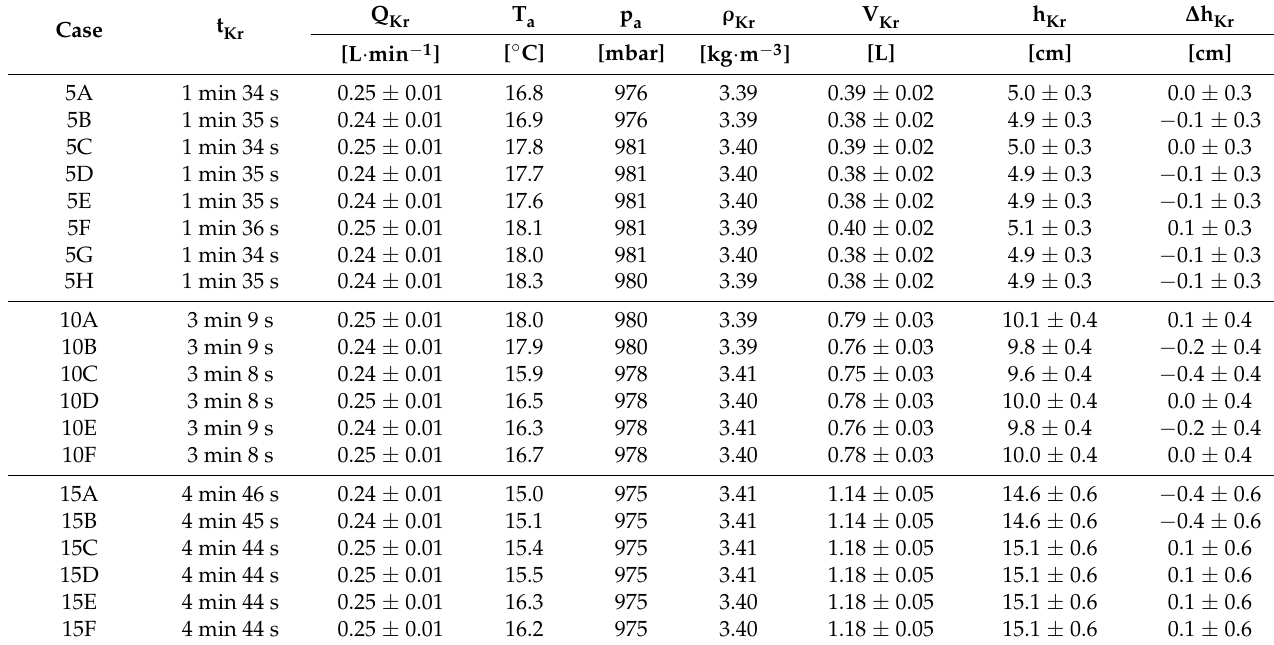
Table 1. Summary of the experimental configurations and associated